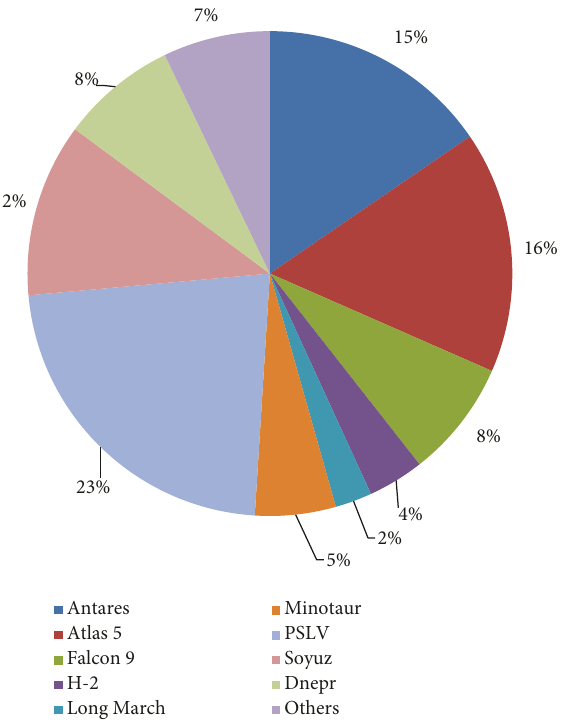
Figure 16: Main CubeSat launchers.